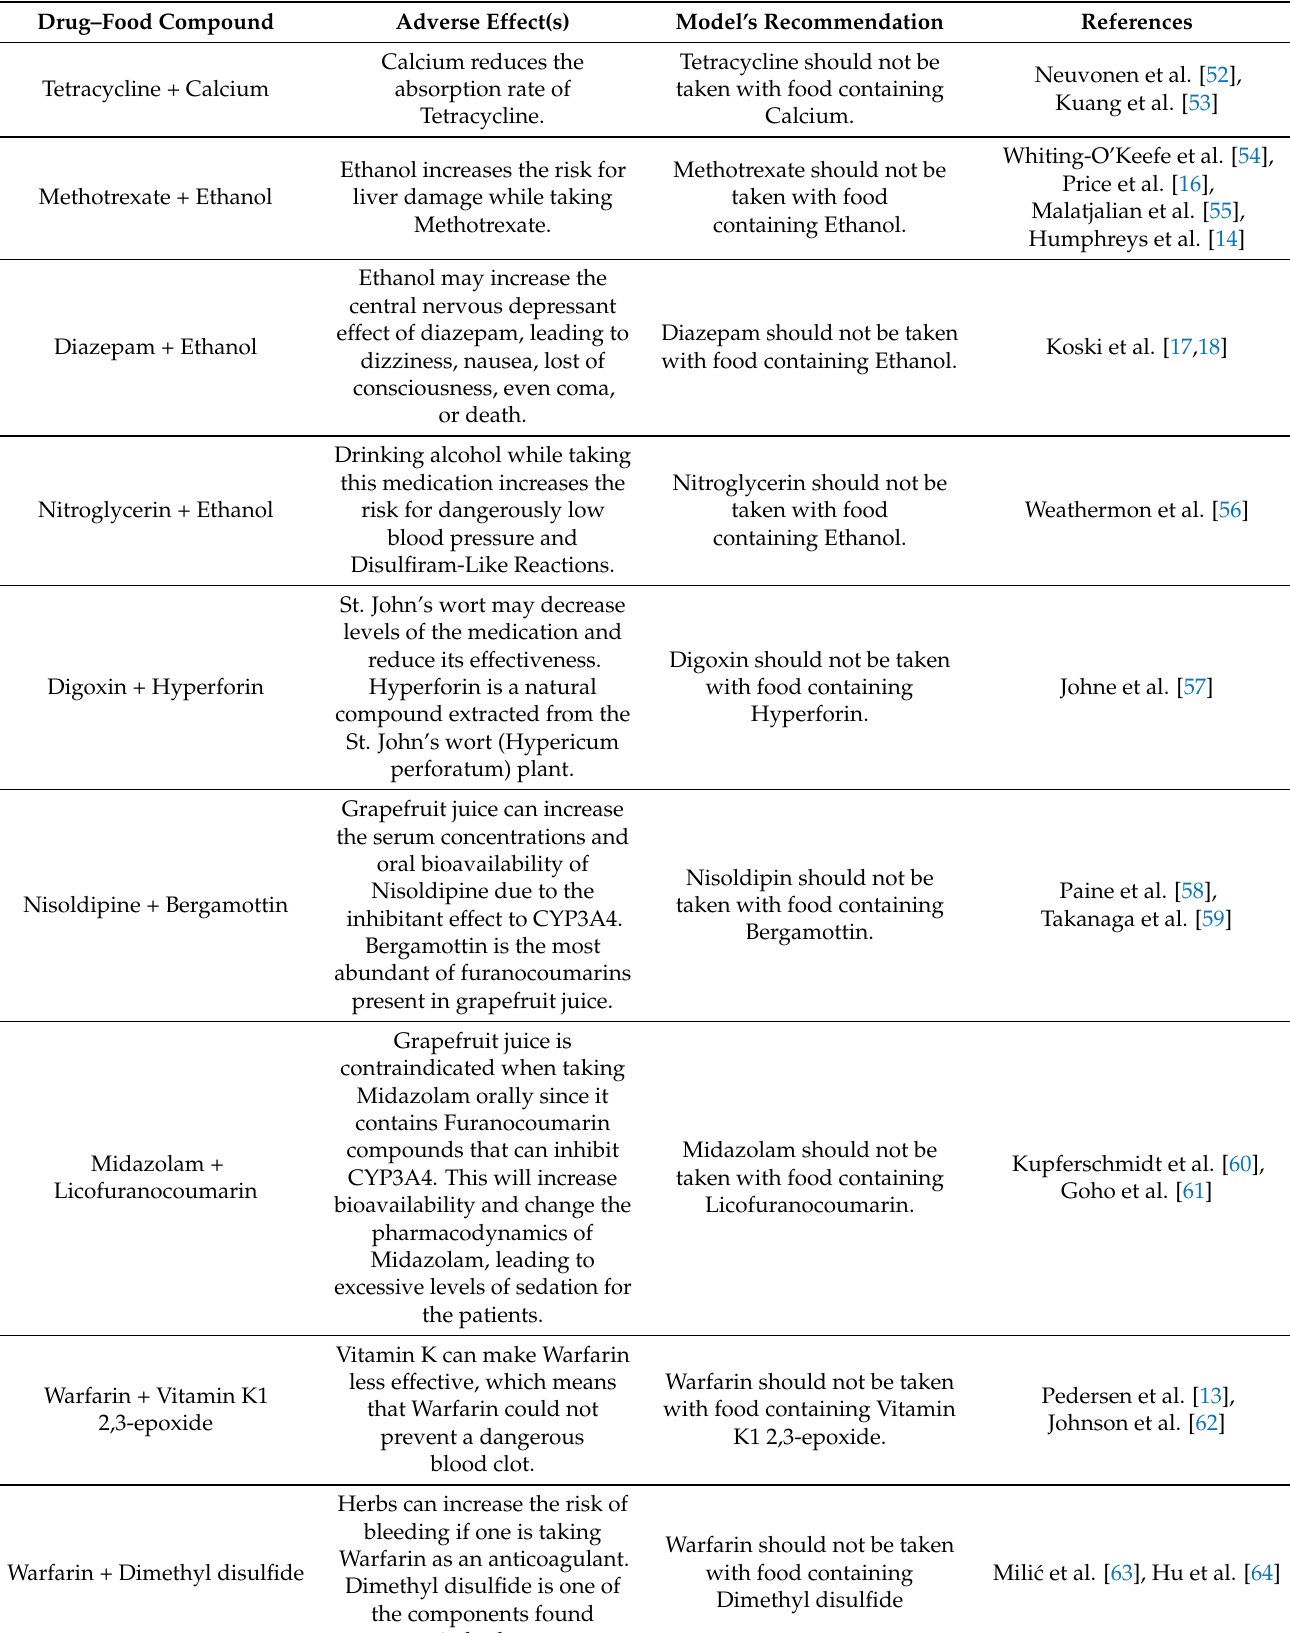
Table 5. Interpretation of our XGBoost-based model to clinical